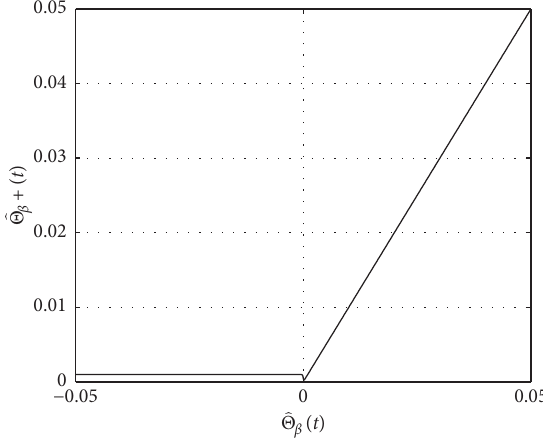
Figure 2: Parametric projection of 􏽢 θ